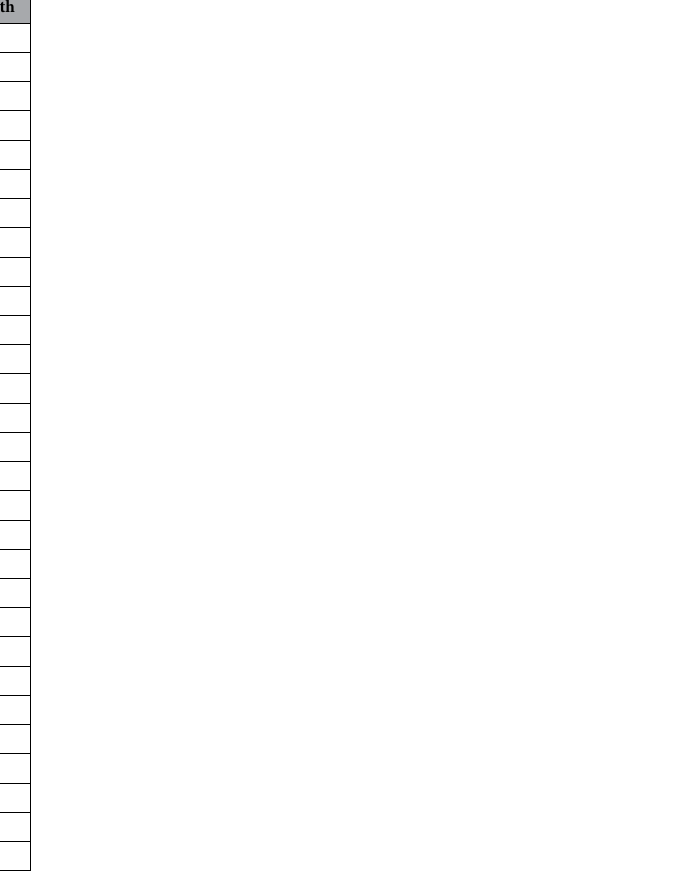
Table 3. The length of Sarouq